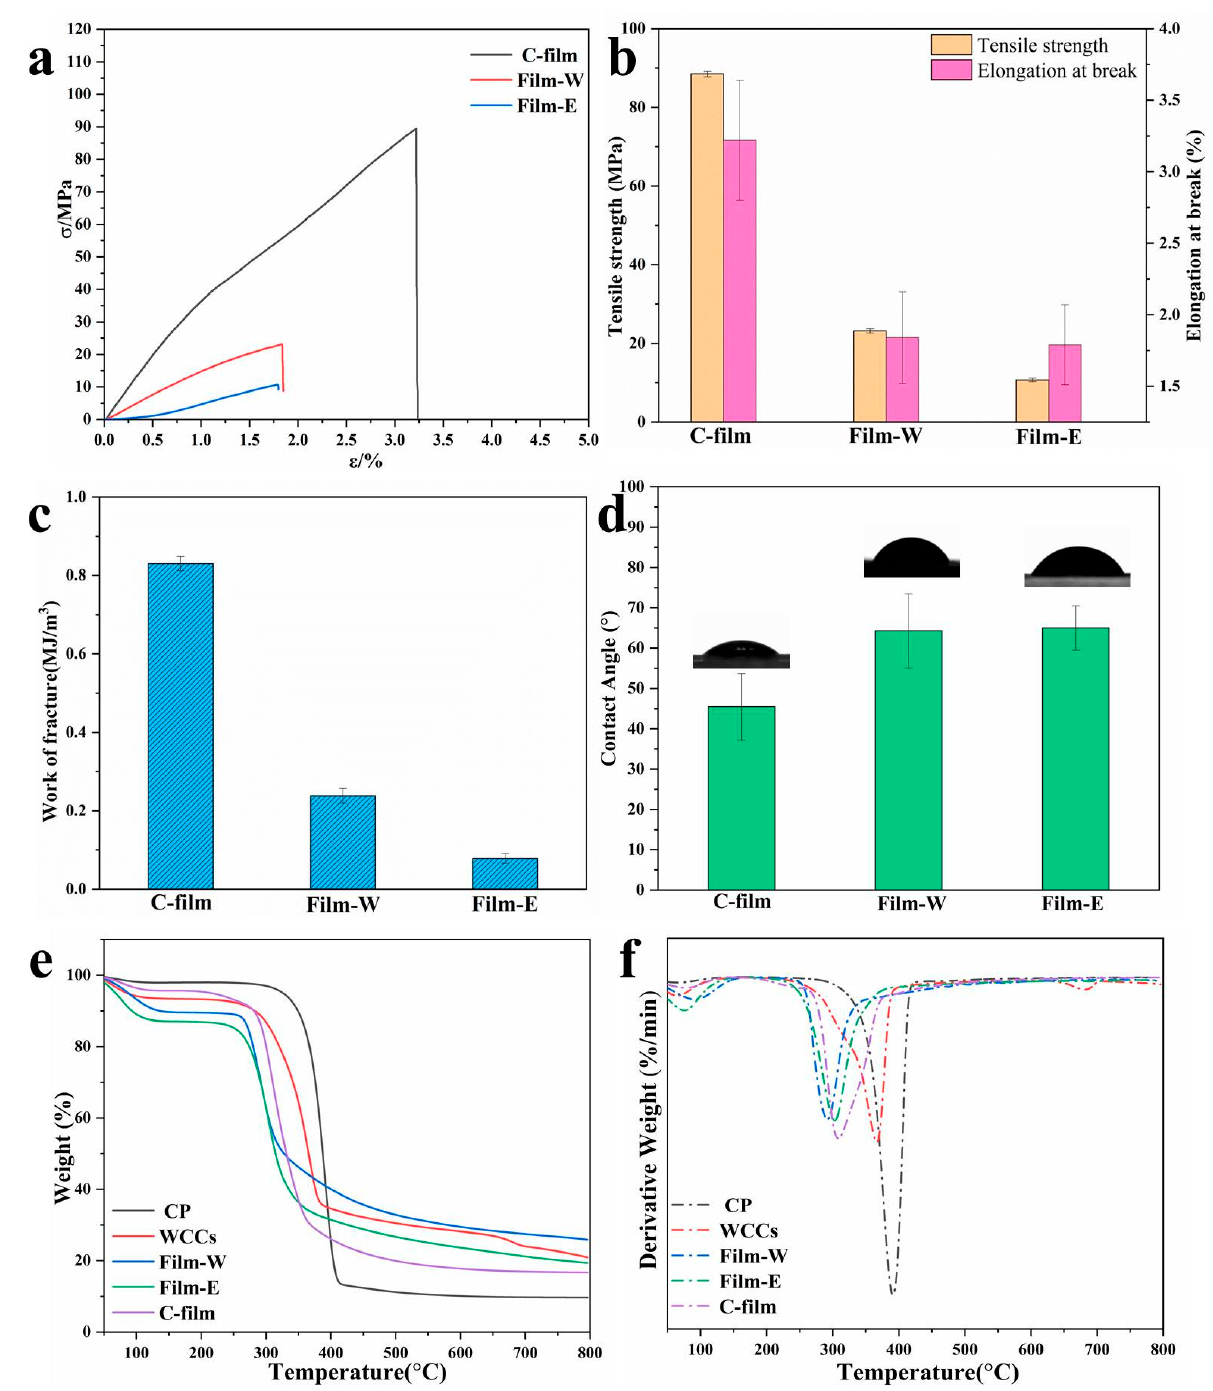
Figure 5. ( a ) Stress–strain profiles, ( b ) tensile strength and elongation at break, and ( c ) work of fracture of C-film, Film-W and Film-E; ( d ) water contact angle of C-film, Film-W and Film-E; ( e ) TG and ( f ) DTG of CP, WCCs, C-film, Film-W and Film-E.